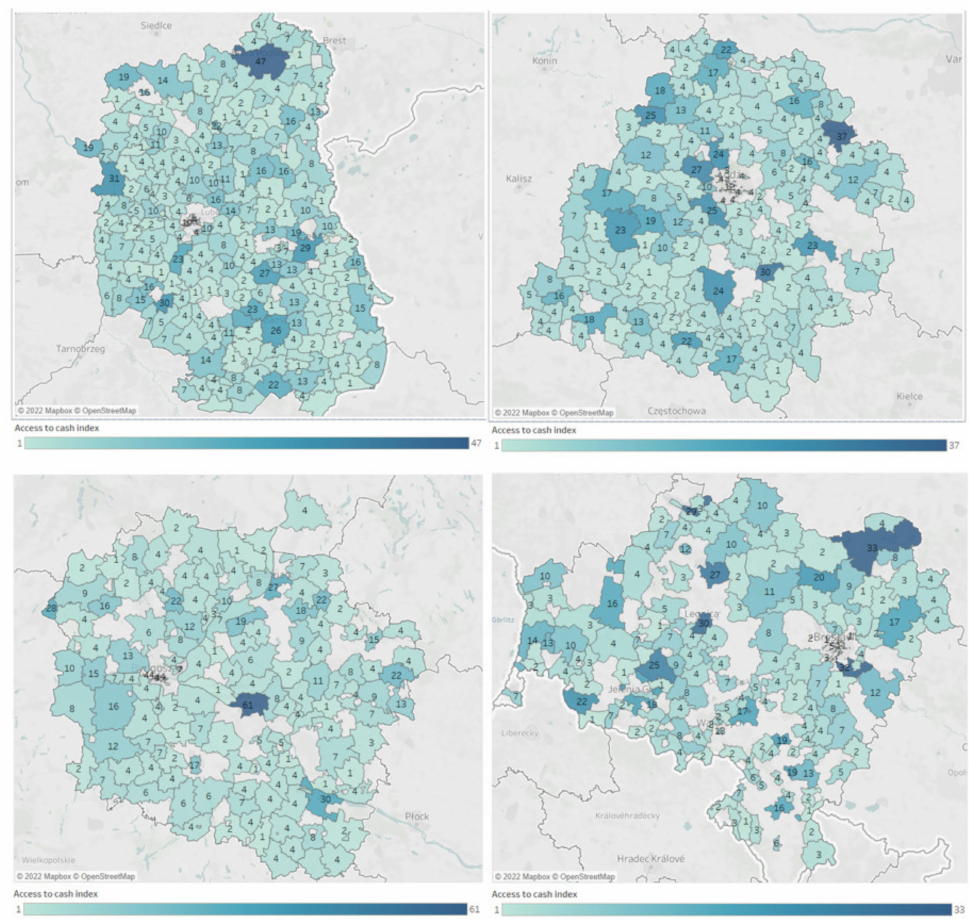
Figure 5. Results of the Access to Cash index in Lubelskie, Ł ó dzkie, Kujawsko-Pomorskie and Dol- no´sl ˛askie voivodships. Source: Prepared by the authors using Tableau Desktop Professional